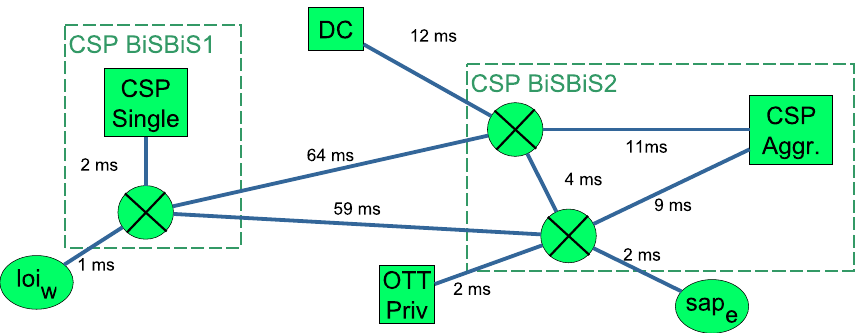
Figure 3. Demonstration of modeling an abstract view of the heterogeneous computation and network infrastructure (rented from the CSP and CP) of Figure 1. This figure shows the topological information which is used by the OTT SP’s orchestration logic to deploy services across the abstract multi-domain